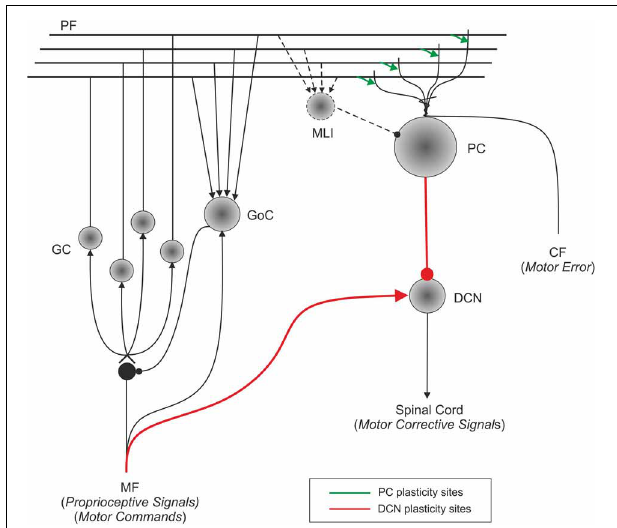
FIGURE 1 | Schematic representation of the main cell types in the cerebellum and of their connections. Suggestions about the nature of inputs signals are indicated [according to Schweighofer et al. (1998b)]. The pathways involved in long-term synaptic plasticity are drawn in green (for DCN afferents) and blue (for PC afferents). PF, parallel fiber; MF, mossy fiber; CF, climbing fiber; GC, granule cell; GoC, Golgi cell; PC, Purkinje cell; DCN, deep cerebellar nuclei; IO, inferior olive; MLI, molecular layer